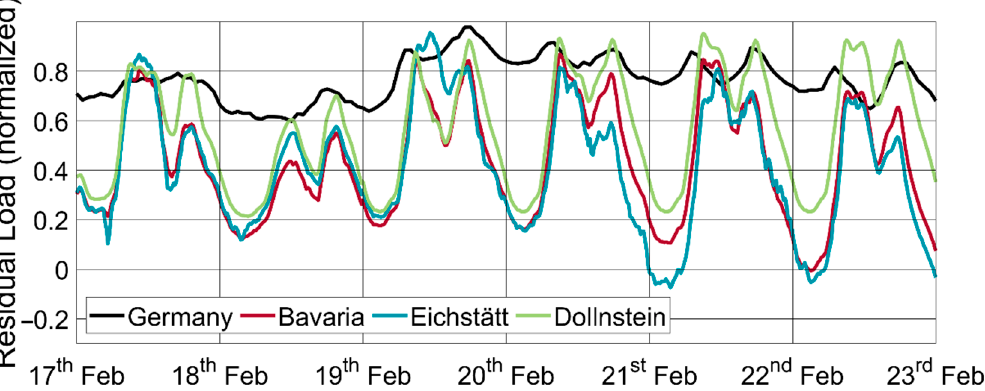
Figure 2. Comparison of the normalized residual load curves in Germany , and the German regions Bavaria , Eichstätt , and Dollnstein from 17th February until 22nd February. Bavaria , Eichstätt , and Dollnstein from 17th February until 22nd